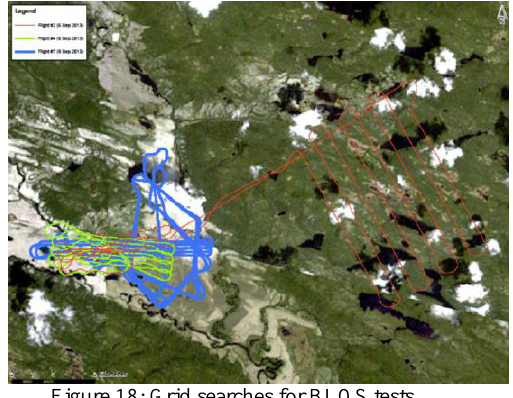
Figure 18: Grid searches for BLOS tests